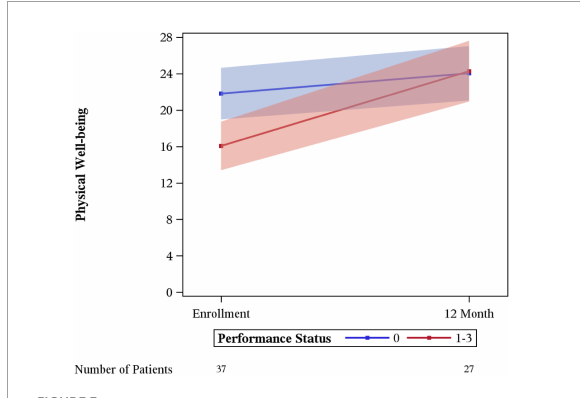
FIGURE3 Changes in physical wellbeing by performance status.